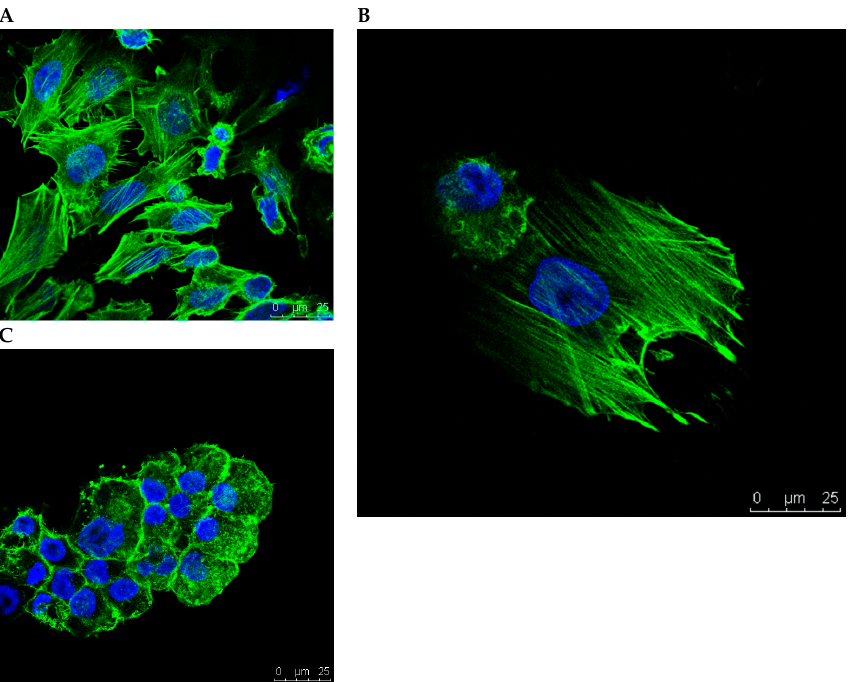
Figure 3. In the 1-g control group, cells showed longitudinal alignment of the actin filaments ( A ). Under simulated microgravity, cells showed spherical arrangement of the actin filaments in the outer regions of the cytoplasm, accentuated in the region of the cell membrane. This occurred in the adherent cells ( B ) and was even more pronounced in the spheroids ( C